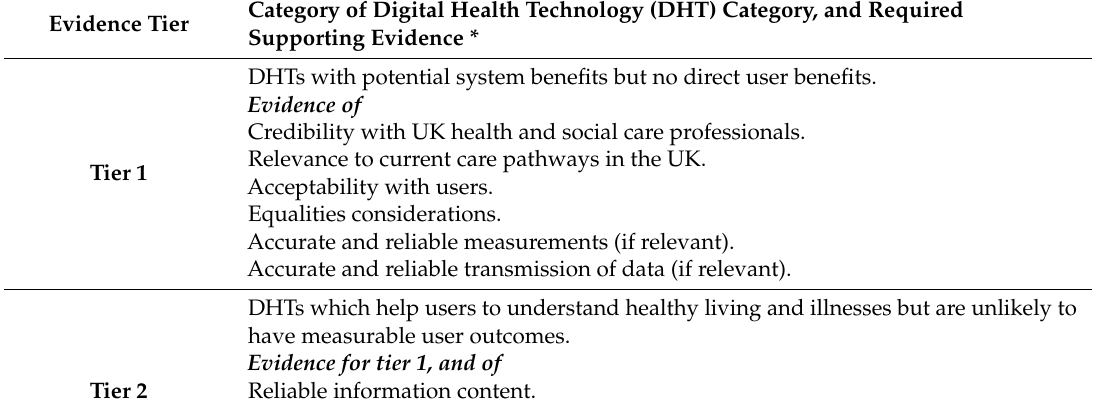
Table 5. Evidence tiers for DHTs as classified by functional